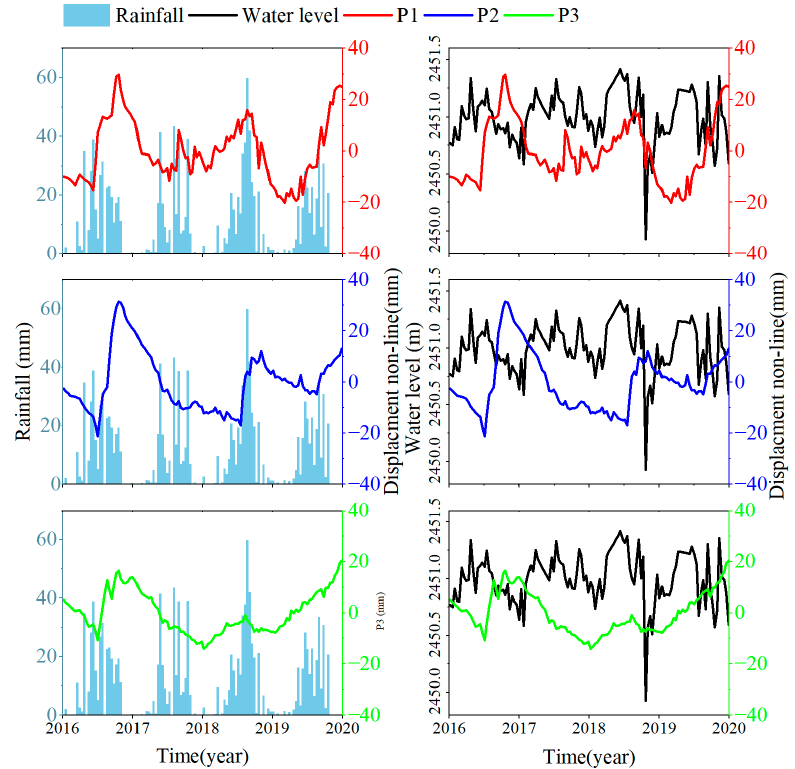
Figure 9. Graph of rainfall, reservoir water level, and nonlinear deformation component of feature points.